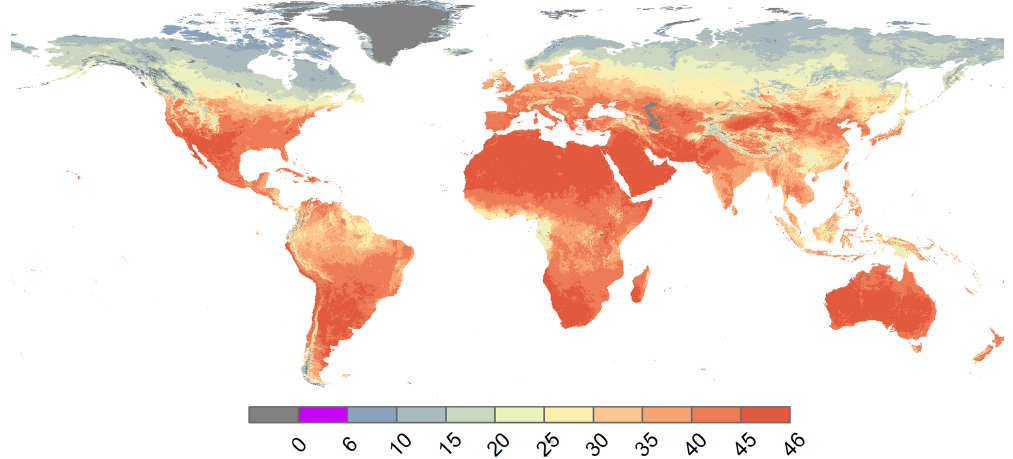
Figure 10. Global map of the number of clear-sky snow/ice-free MOD09A1 observations in 2020.